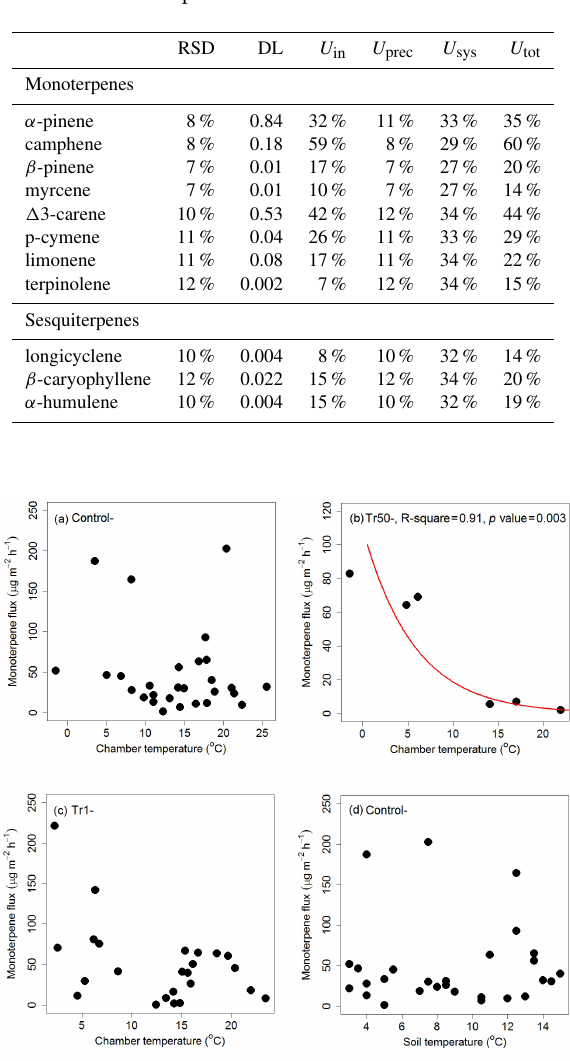
Table A2. Relative standard deviation between the parallel samples taken from the chamber enclosures (RSD, %), the detection limit of the VOC quantification (DL, µgm − 2 h − 1 ) , and errors due to variation in ingoing air concentration ( U in , %), and based on these values, precision ( U prec , %), systematic error ( U sys , %), and total uncertainty ( U tot , %) of the emissions were calculated for the emissions at the level 10µgm − 2 h − 1 , which was mean emission rate of α -pinene.